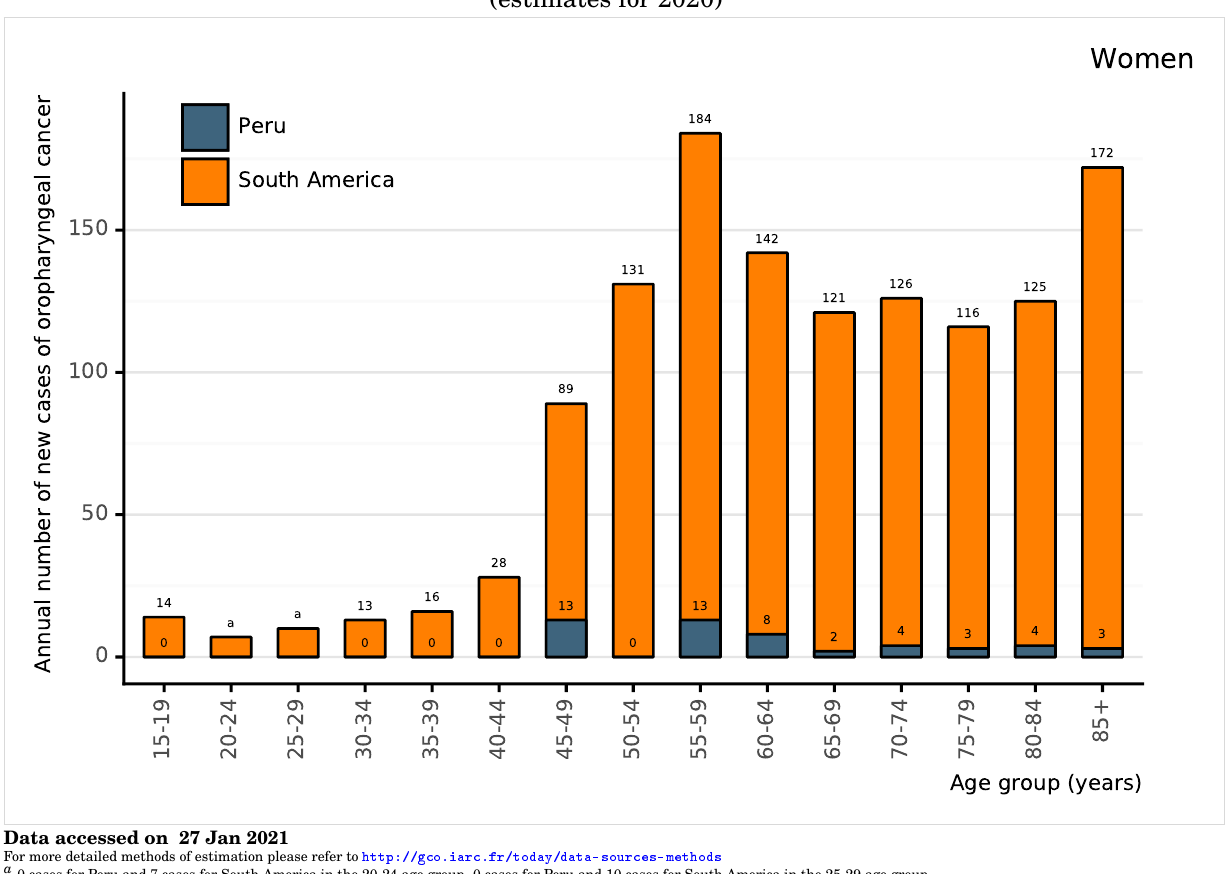
Figure 92: Annual number of new cases of oropharyngeal cancer among women by age group in